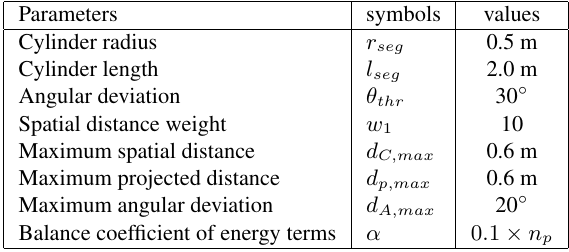
Table 1. Control parameters for the single tree stem detection method; n p refers to the number of points inside the